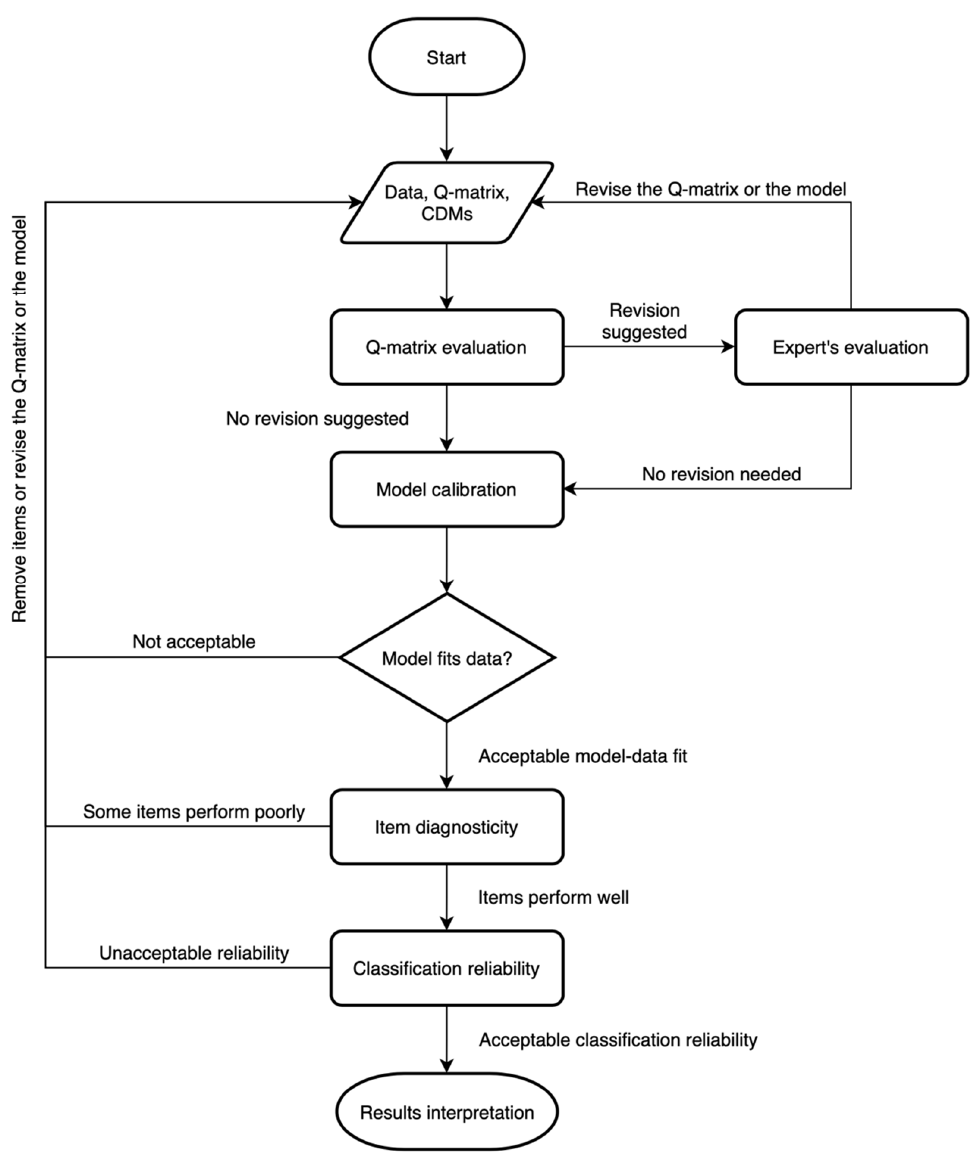
Figure 1. Data analysis diagram using the G-DINA model.